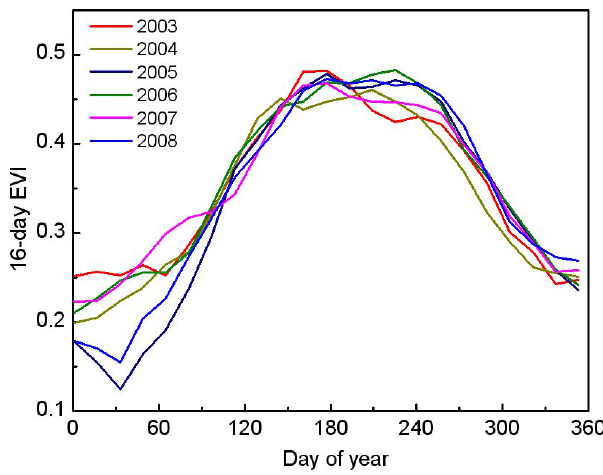
Fig. 3. Temporal curves of 16-day MODIS EVI for the coniferous plantation covered region around QYZ site. The EVI value was the average of forest pixels in this region (10km by